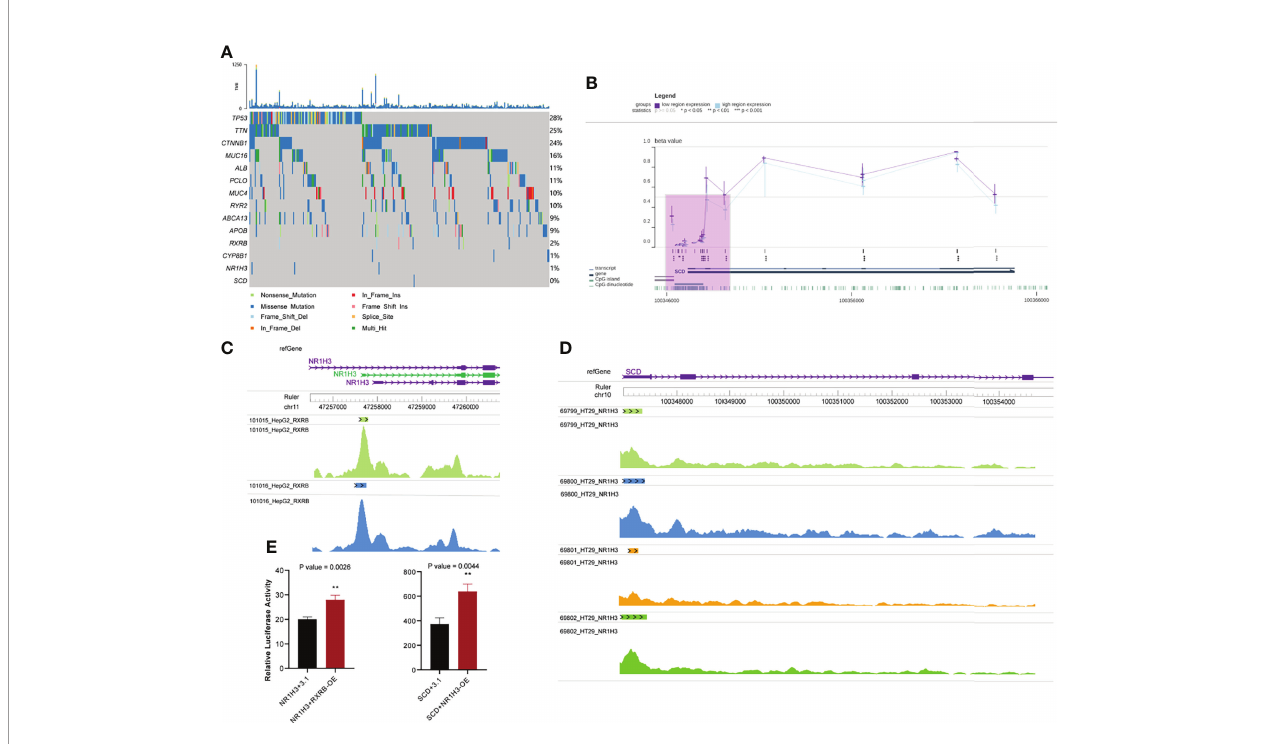
FIGURE 5 | Other omics analysis of key genes. (A) Somatic mutations in the top 10 mutated genes and key genes in the PPAR signaling pathway. (B) Visualization of methylation of the SCD promoter region in HCC. The purple shaded area represents the SCD promoter region (C) Chips of RXRB bind to the promoter region of NR1H3 . (D) Chips of NR1H3 bind to the promoter region of SCD . (E) Relative dual luciferase activities of NR1H3 and SCD promoters were determined at 48 h in MHCC-97h cells (Left: NR1H3 ; Right: SCD . pcDNA3.1-RXRB and pcDNA3.1-NR1H3 plasmid were empty pcDNA3.1 plasmids as the control). Data results were shown as mean ± SEM (n ≥ 3). P-values were calculated by two-tailed t-tests. **P<0.01; OE, overexpression; SEM, standard error of the